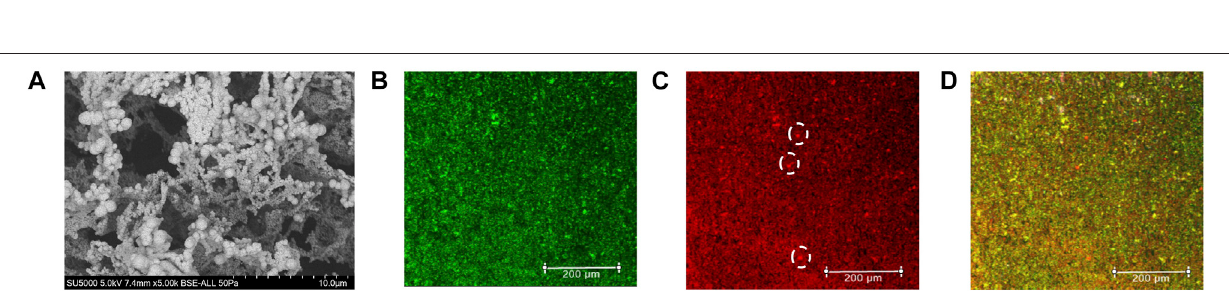
Frontiers in Sensors |